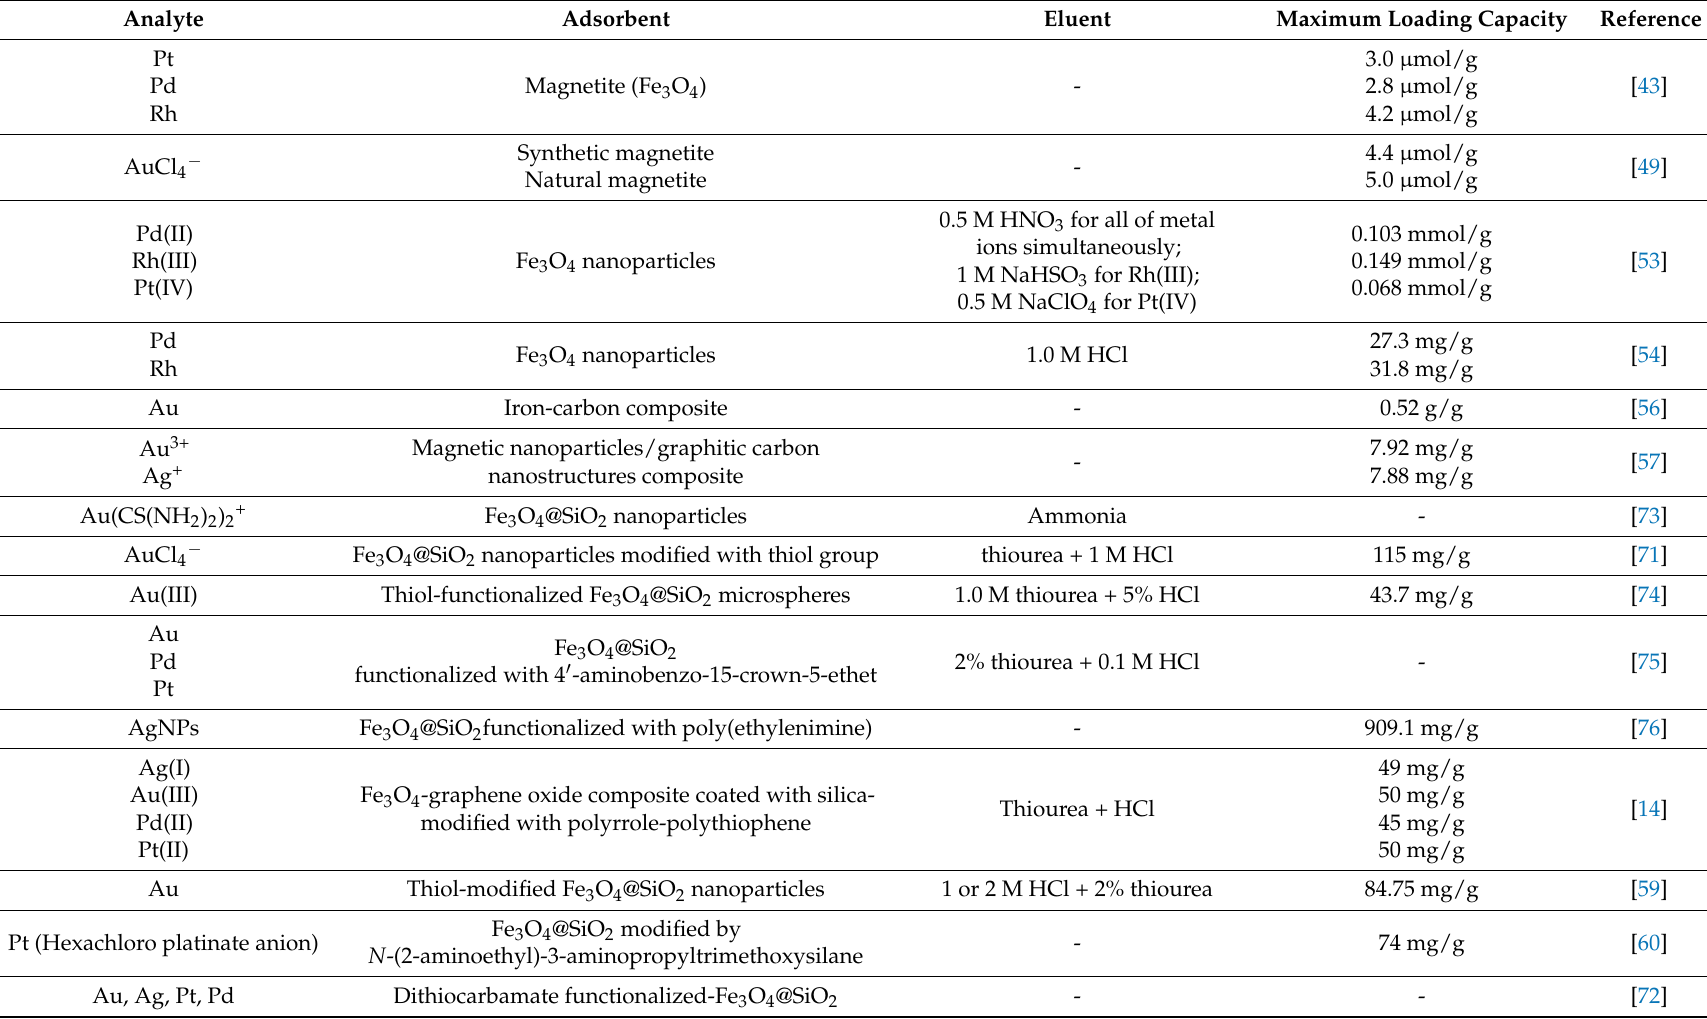
Table 1. Magnetic adsorbents for the recovery of precious metals from